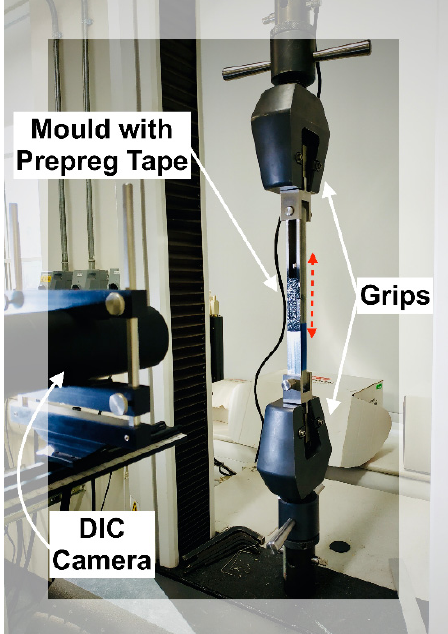
Figure 12. Experimental set-up for preload estimation.